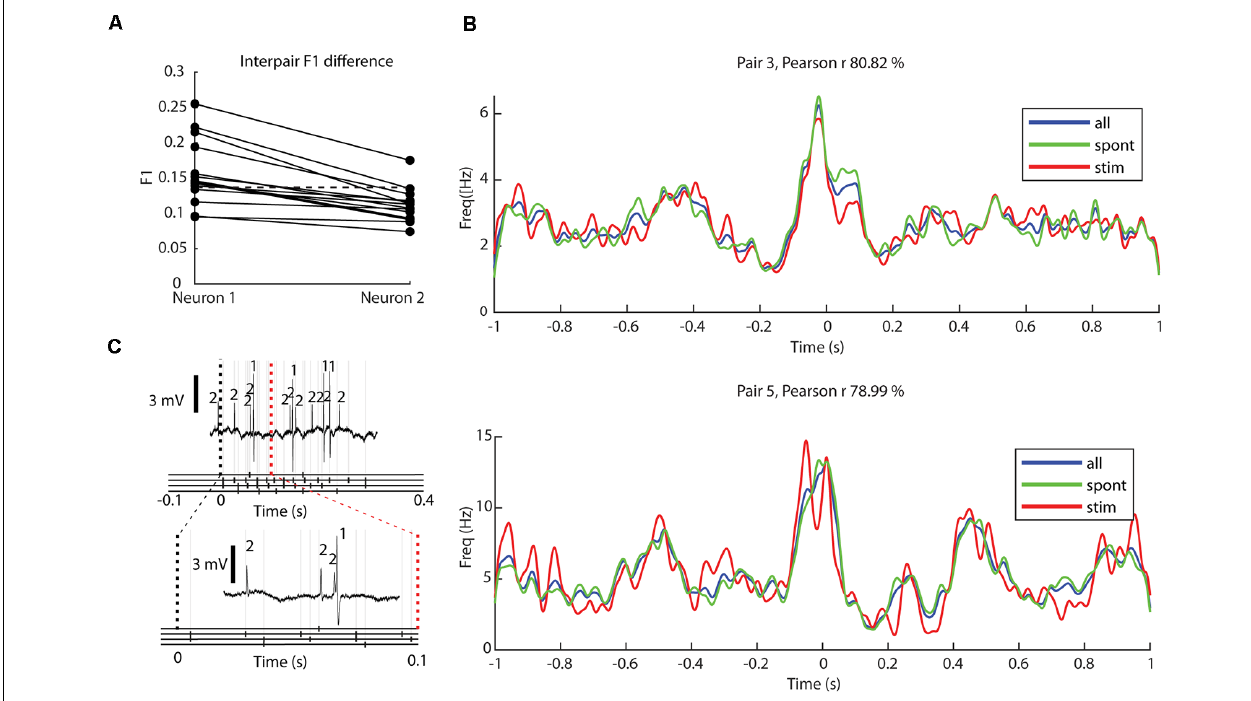
FIGURE 5 | Decoding of tactile input patterns and impact of ongoing tactile input on correlation patterns. (A) The levels of decoding (F1 score) for eight specific tactile input patterns delivered to digit 2 for each neuron ( N = 28). Neurons of the same pair are shown in separate columns and are connected with solid lines, where the neuron with the higher decoding is shown to the left. The dashed horizontal line indicates the limit where neurons were defined to be able to decode the tactile afferent input patterns (Wahlbom et al., 2021). (B) For two sample neuron pairs, superimposed correlation patterns for all recorded activity (blue), only activity occurring during ongoing tactile input patterns (red), and only activity excluding periods of ongoing tactile input patterns (spontaneous; green). For each sample neuron pair, the Pearson correlation coefficient between the latter two conditions (green and red curves) is indicated. (C) A sample raw trace showing the response of a neuron pair to one of the eight presented stimulation patterns (top) with a magnified trace below. Below each trace, the presented stimulation pattern is shown, with the occurrence of each electrical pulse shown with black markers in the corresponding stimulation channel, with light gray lines extending upwards.